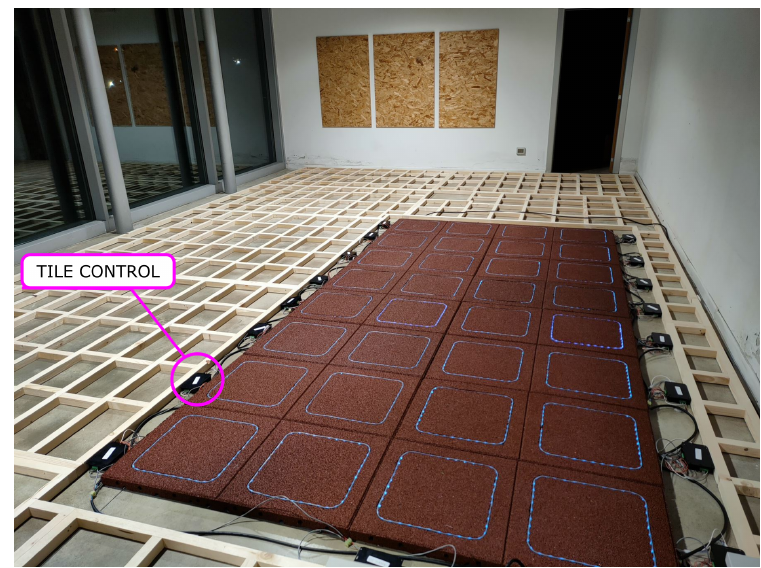
Figure 7. View of the demonstrator site assembly.